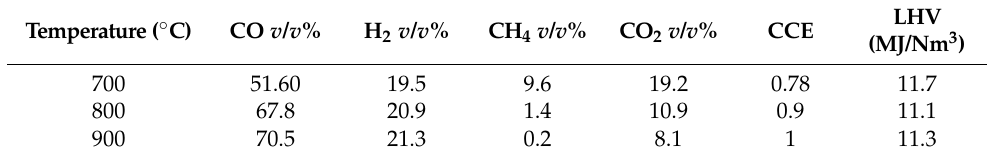
Table 9. Composition for syngas of (steam + oxygen) gasification for ER = 0.3 and SBR = 0.5 at 900 ◦ C. Temperature ( ◦